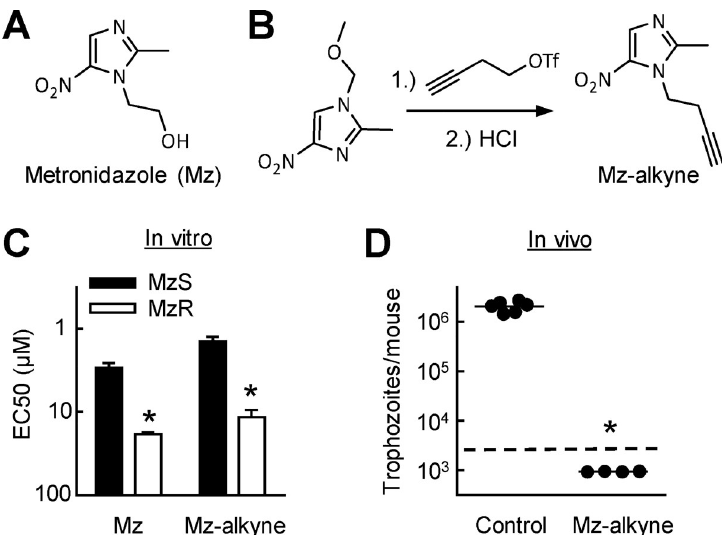
Fig 2. Synthesis and antigiardial activity of Mz-alkyne. A. Structure of metronidazole (Mz). B. Scheme of two-step synthesis of an alkyne-labeled derivative of Mz (Mz-alkyne). C. In vitro activity of Mz and Mz-alkyne against Mz- sensitive (MzS) and Mz-resistant (MzR) congenic strains of G . lamblia WB, as determined by EC50 assay. Results are shown as mean + SD (n = 3 independent experiments; � p < 0.01 vs MzS cells). D. In vivo efficacy of Mz-alkyne against G . lamblia WB in a suckling mouse model of giardiasis. Starting one day after infection, mice were treated orally with a daily dose of 10 mg/kg Mz-alkyne for three days, or given PBS as a control, and trophozoites were enumerated in the small intestine. Each data point represents one animal; horizontal lines show the geometric means ( � p < 0.05 vs control). The dashed line depicts the assay sensitivity.